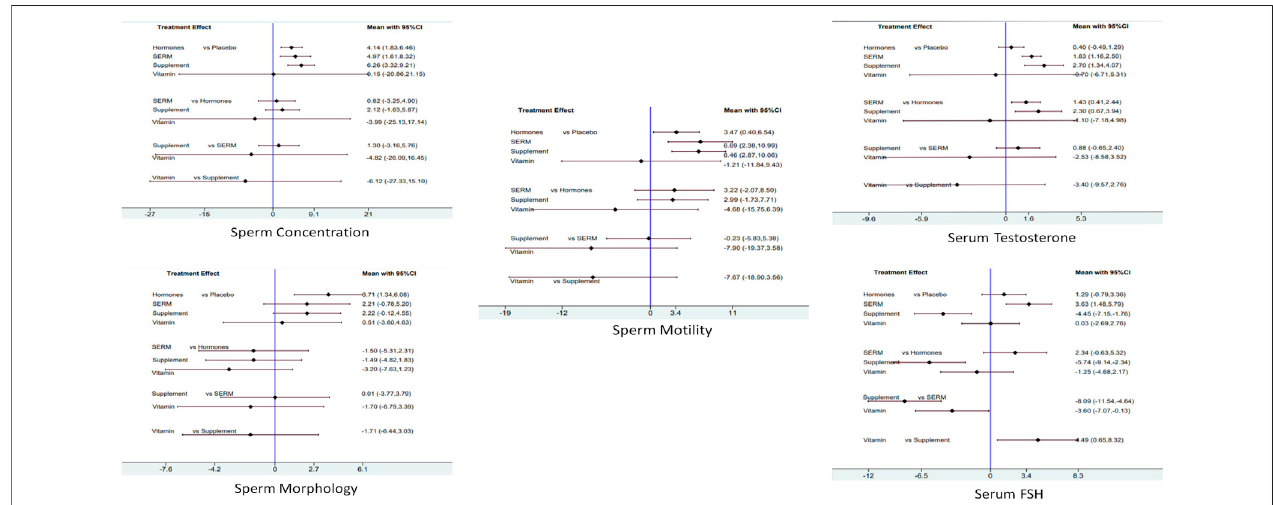
FIGURE 5 | Network meta-analysis estimates of change in primary and secondary clinical outcomes of infertile male patients. Sperm concentration, sperm morphology, sperm motility, serum total testosterone, and serum FSH.